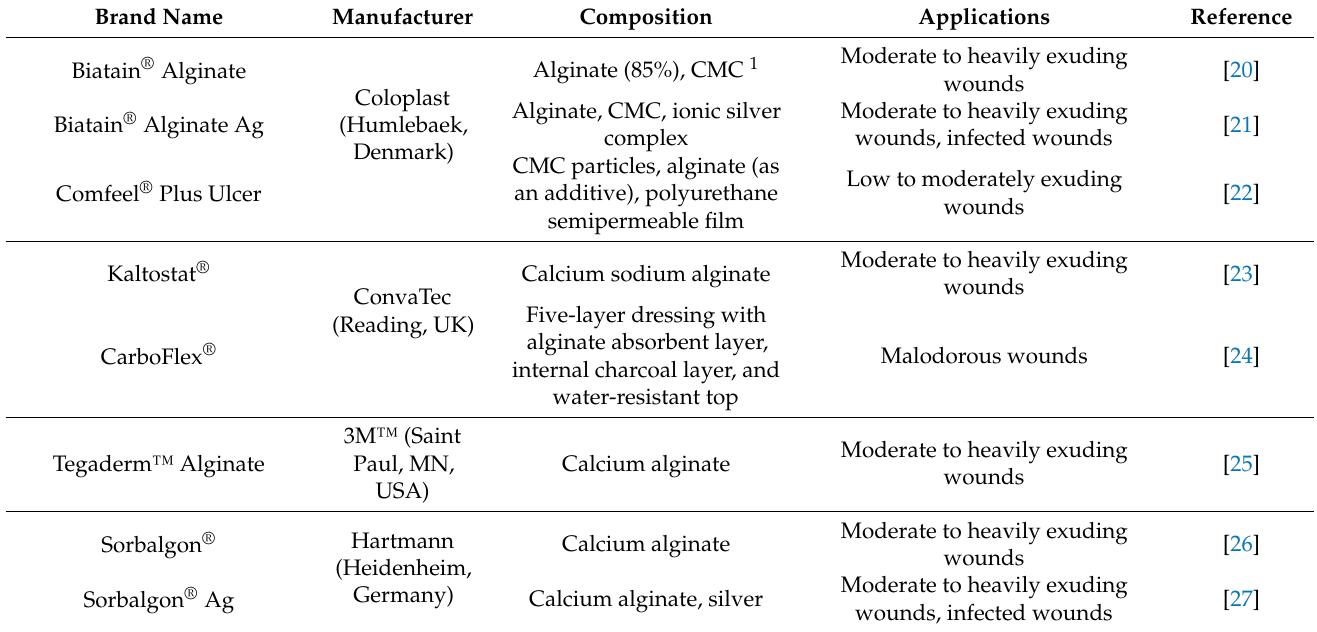
Table 1. The examples of commercially available alginate-based wound